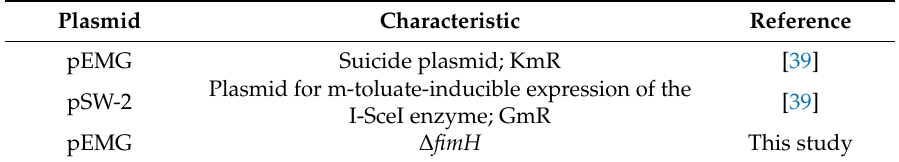
Table 2. Bacterial plasmids used in this study.